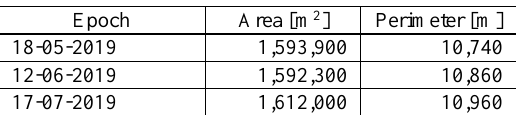
Table 3. Lake surface area and perimeter per